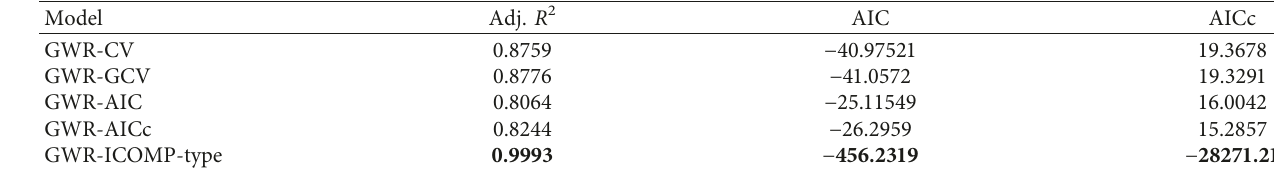
Table 6: Model performance evaluation.